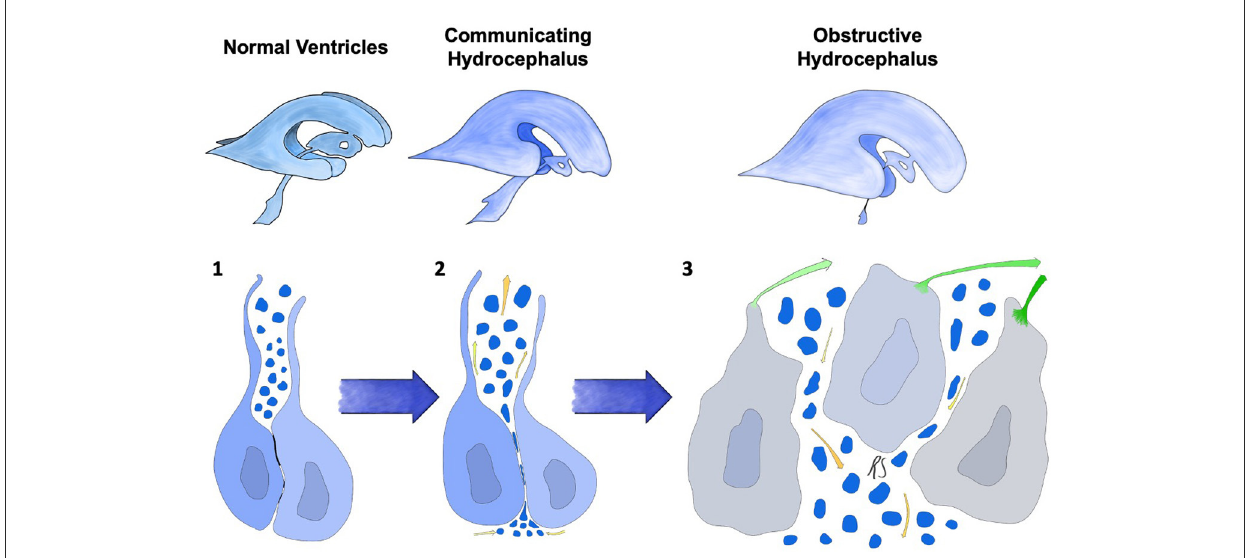
FIGURE3 Progression of ependymal failure and development of hydrocephalus. (1) normal ependyma with intact junctions, solute/CSF interchange is maintained. (2) junctional damage with increased transependymal flow toward the ventricles represented by yellow arrows and water particles penetrating into the ependymal layer. This could be caused by an osmotic gradient secondary to high CSF protein concentration. A form of communicating hydrocephalus may develop at this stage. (3) failure and collapse of the ependymal layer, with denudation of the ventricular wall and aqueductal/subarachnoid occlusion. This mechanism could lead to obstructive hydrocephalus. Green arrows represent ependymocytes detaching from the ependymal basement membrane and causing ventricular denudation. Trans-ependymal flow of water and solutes is at this point uncontrolled, leading to additional ventricular enlargement, further ependymal distension and